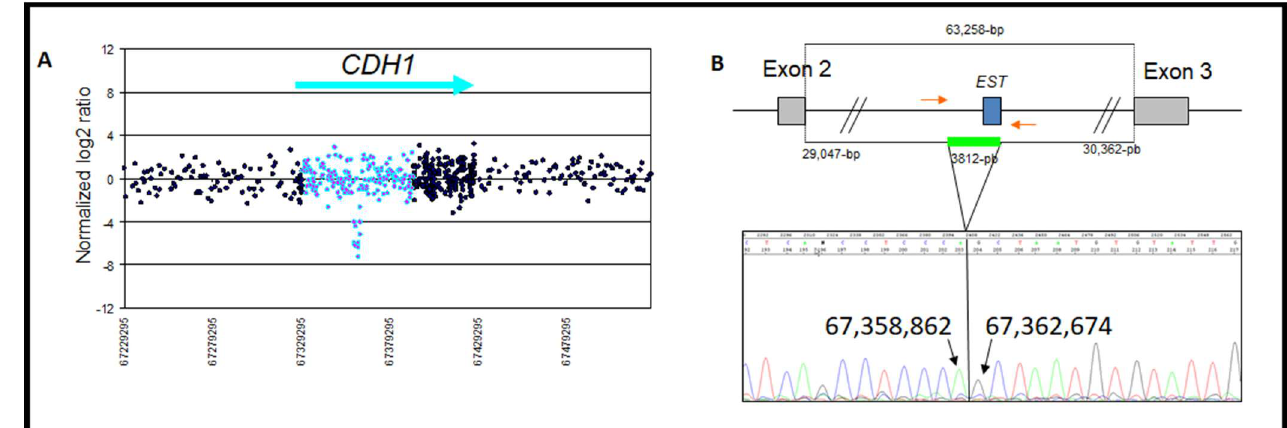
Figure 3. ( A ) Array CGH profiles obtained for the heterozygous intron 2 deletion of the C DH1 gene. Intron 2 is represented in blue dots. ( B ) Sequencing chromatogram of the mapped breakpoint for the intron 2 deletion from chr16: 67,358,862–67,362,674 (NM_0043603: c.163+29048_c.164−30401del). Gray box: exons; blue box; EST; green line: deletion locus. Red arrows: position of sequencing primers.